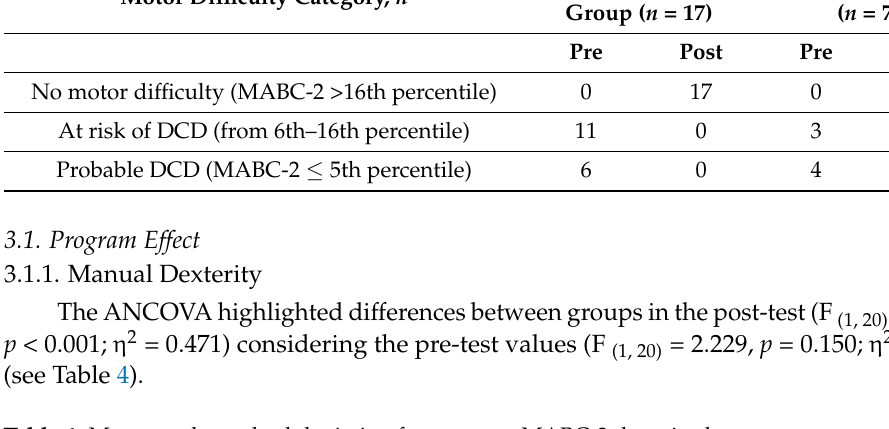
Table 4. Means and standard deviation for post-test MABC-2 domains by groups.